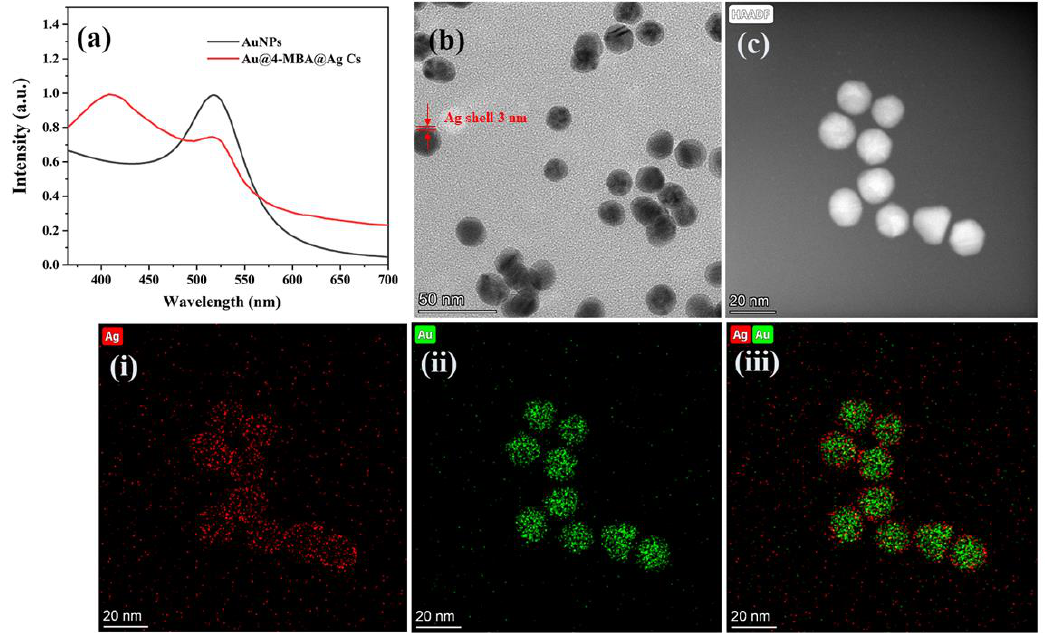
Figure 2. ( a ) UV-vis spectra of AuNPs and Au@4-MBA@Ag; ( b ) transmission electron micrographs of Au@4-MBA@Ag; ( c ) HAADF image of Au@4-MBA@Ag and the corresponding element mapping images ( i – iii